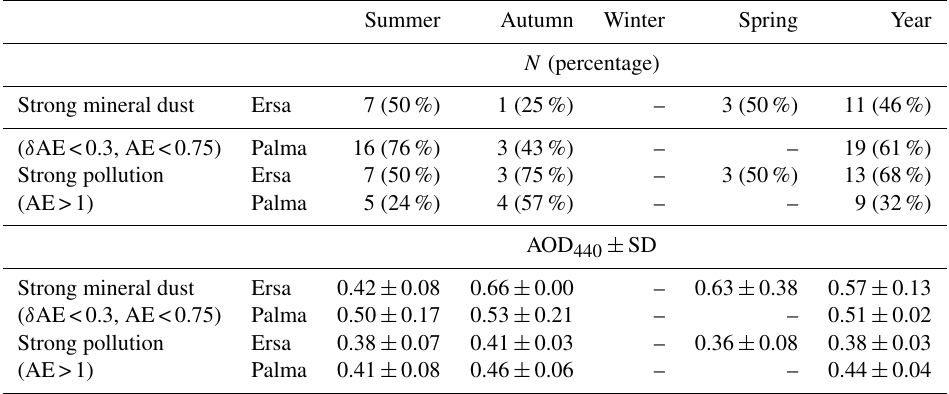
Table 2. Seasonal number with their standard deviation (and percentage of data in parenthesis) and aerosol optical depth at 440nm (AOD 440 ; ± standard deviation) for the pairs ( δ AE, AE) of Ångström exponent difference ( δ AE) and Ångström exponent (AE) fulfilling ( δ AE<0.3, AE<0.75) and corresponding to strong mineral dust outbreaks and fulfilling (AE>1) and corresponding to strong pollution events. The data are those of Fig. 8 (AERONET level 2.0 daily inversion products available for the period 2011–2015, which means that the following criteria apply on these data: 50<solar zenith angle<80 ◦ and AOD 440